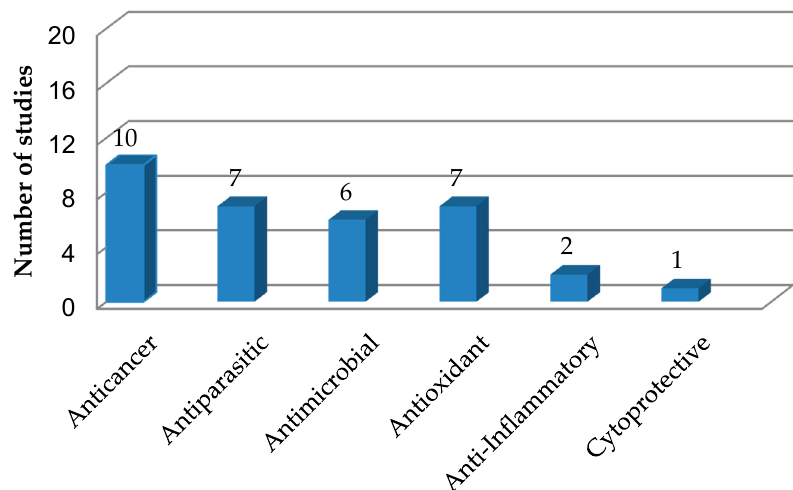
Figure 2. Quantification and classification of in vitro studies on solid dispersions published in the period from 2009 to 2020.